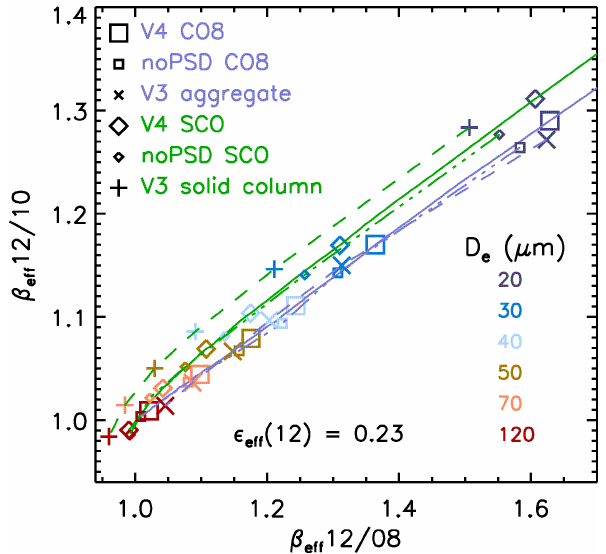
Figure 10. V4 ice LUTs, showing β eff 12 / 08 ( x axis) vs. β eff 12 / 10 ( y axis) for the CO8 model (squares and purple lines) and the SCO model (diamonds and green lines) for six values of D e between 20 and 120µm. The LUT values are shown for ε eff , 12 = 0 . 1 (dotted lines) and = 0 . 9 (dashed–dotted lines). The solid lines represent the approximate LUT values derived from Parol et al. (1991).